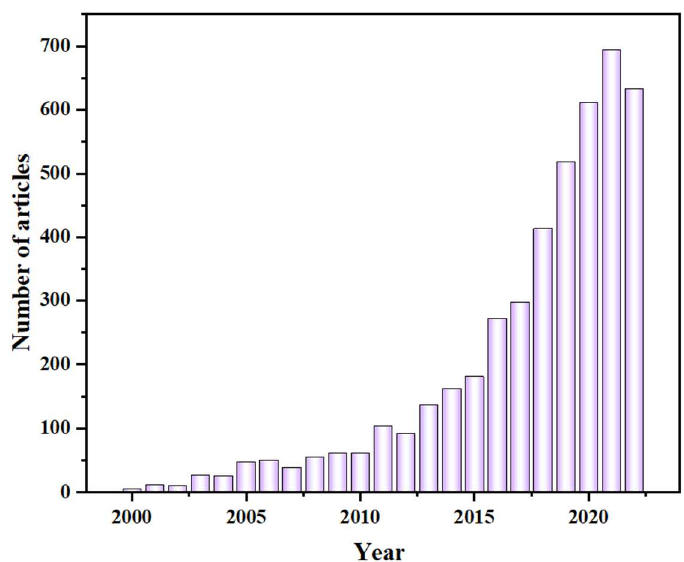
Figure 2. Total number of articles on cellulose adsorbents.